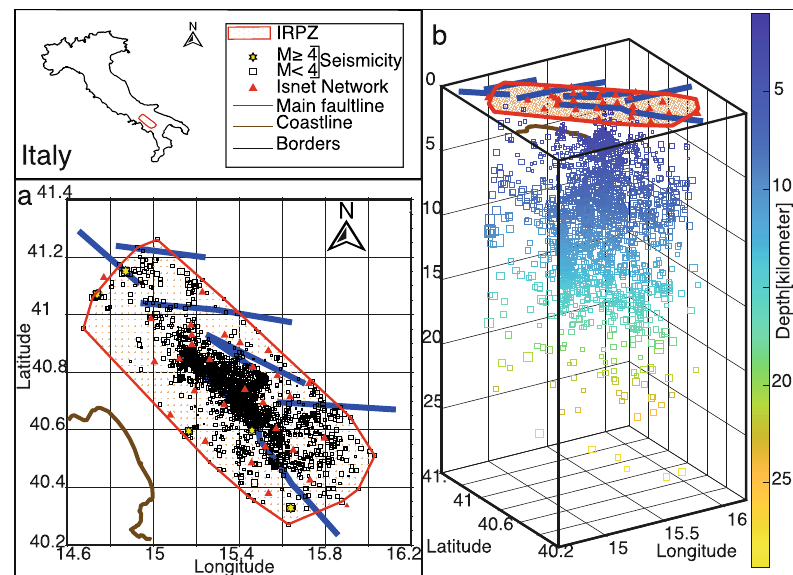
Fig. 2 Seismic dataset recorded by ISNet seismic network in the IRPZ area (southern Italy). Distribution of earthquakes represented in map ( a ) and in 3D ( b ) with size varying according to magnitude and coloured per hypocentral depth. Historical events with larger magnitudes (M up to 7.0; Rovida et al., 2020 54 ) are represented as yellow stars. ISNet seismic stations are shown as red triangles. Normal faults from the Database of Individual Seismogenic Sources (http://diss.rm.ingv.it/diss/) are shown as blue lines. The area considered in this study is limited by a red line.